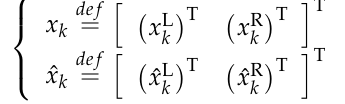
Figure 1. ( Left ) The two MIMU are mounted to the feet separately, the OX b Y b Z b coordinate system are the carrier coordinates; ( right ) side view, the OX n Y n Z n coordinate system are the navigation coordinates.